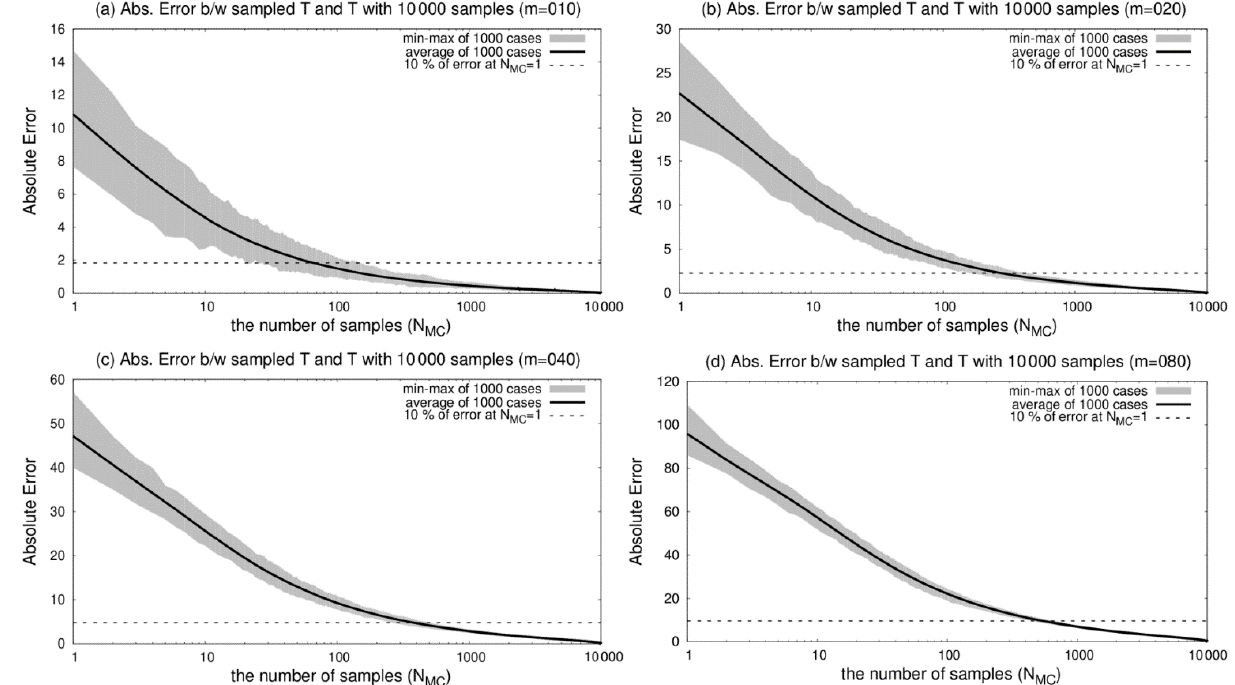
Figure B1. Absolute errors of the transform matrix of MC resampling as a function of the number of samples ( N MC ) verified against the transform matrix with 10000 samples. Absolute errors are computed for 1000 independent cases that have different weights generated by uniform random numbers. Black bold lines show the average of 1000 cases, and gray shades represent minimum and maximum errors of the 1000 cases. Panels (a) – (d) show experiments with 10, 20, 40, and 80 ensembles, respectively. Dashed line shows the 10% of initial error at N MC =